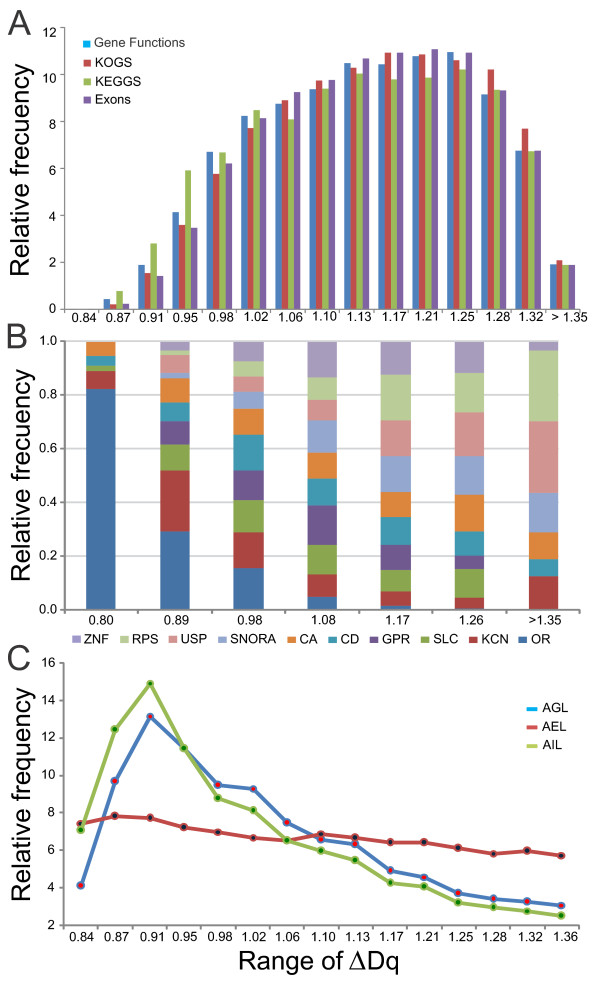
Distributions by gene function, gene family, and gene length: A: Gene functional distributions per RM. These distributions are strongly significant up to 80% of the ranges. B: Percentage of gene families per RM. Gene families: CA: Carbonic anhydrase, CD: cluster of differentiation, GPR: G protein-coupled receptors, KCN: potassium channels, OR: olfactory receptor, RPS: ribosomal proteins, SLC: solute carrier, SNORA: small nucleolar RNA, USP: ubiquitin-specific peptidases, ZNF: Zinc fingers, C2H2-type. C: Degree of gene fragmentation per RM. AGL: average of gene length, R2 ~0.55. AEL: average of exon length, R2 ~0.91. AIL: average of intron length, R2 ~0.74.